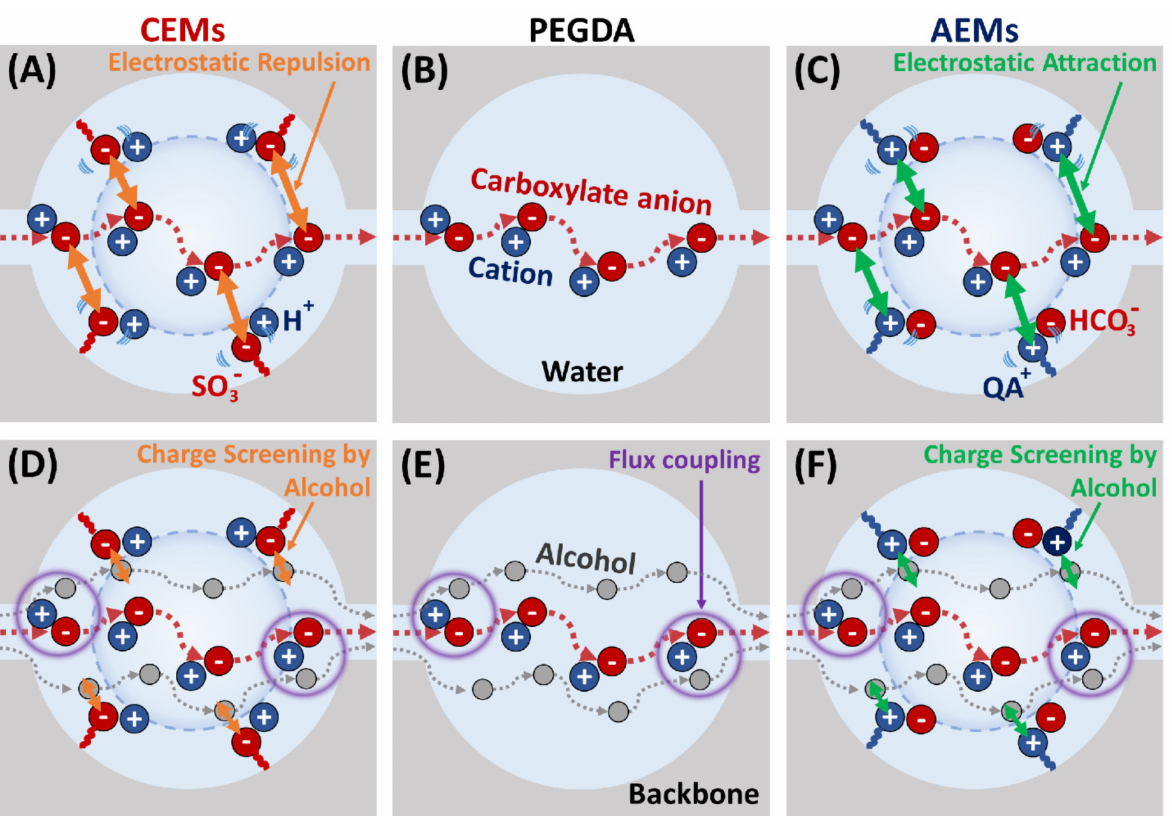
Figure 1. Schematic depiction of carboxylate salt diffusion in ( A , D ) cation exchange membranes (i.e., PEGDA-AMPS and Nafion ® 117), ( B , E ) crosslinked PEGDA (i.e., A0) and ( C , F ) anion exchange membranes (i.e., P8, P12 and AMVN) in ( A – C ) single and ( D – F ) co-diffusion with an alcohol (MeOH or EtOH). Figures are reprinted in part from [28,30,32] with permission from Elsevier and